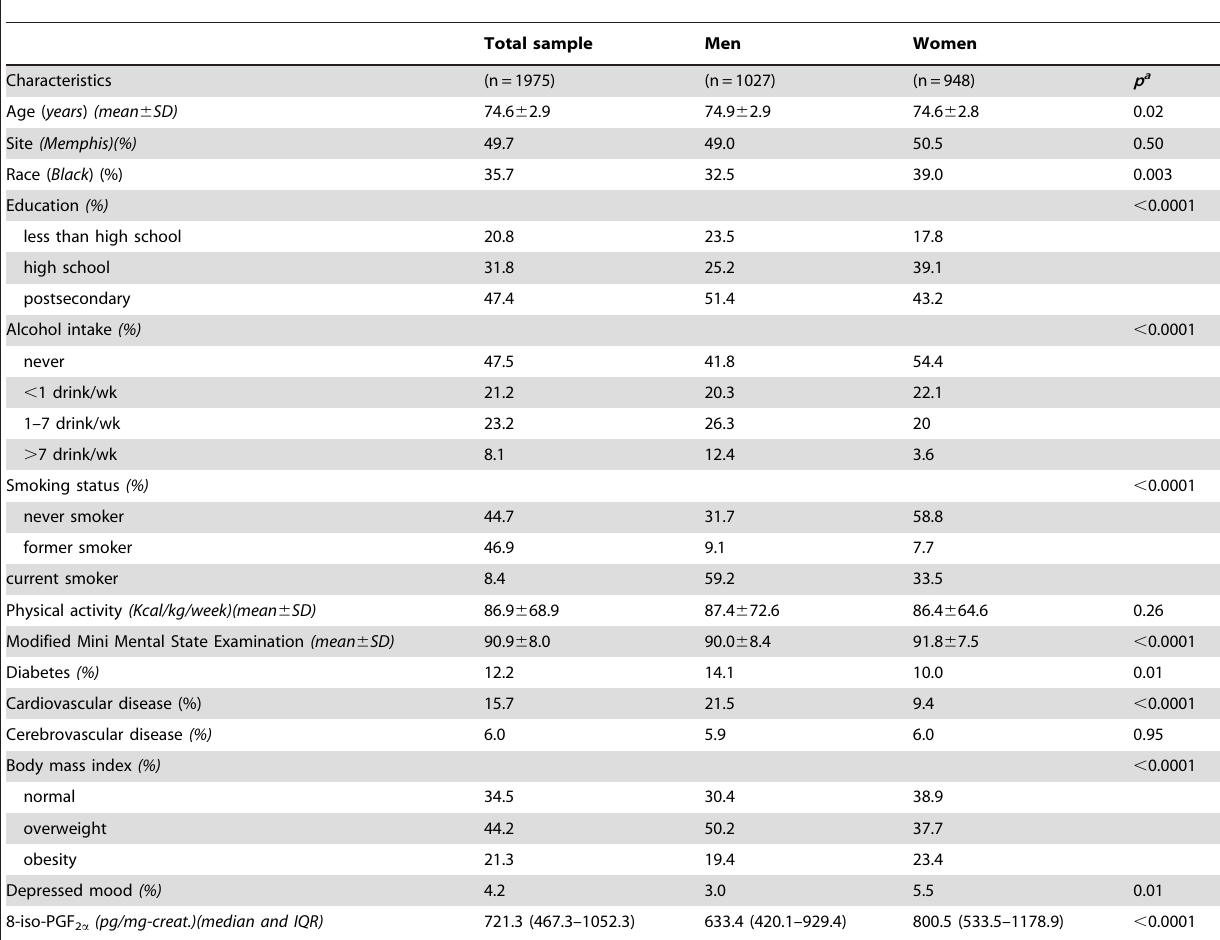
Table 1. Main characteristics of the study